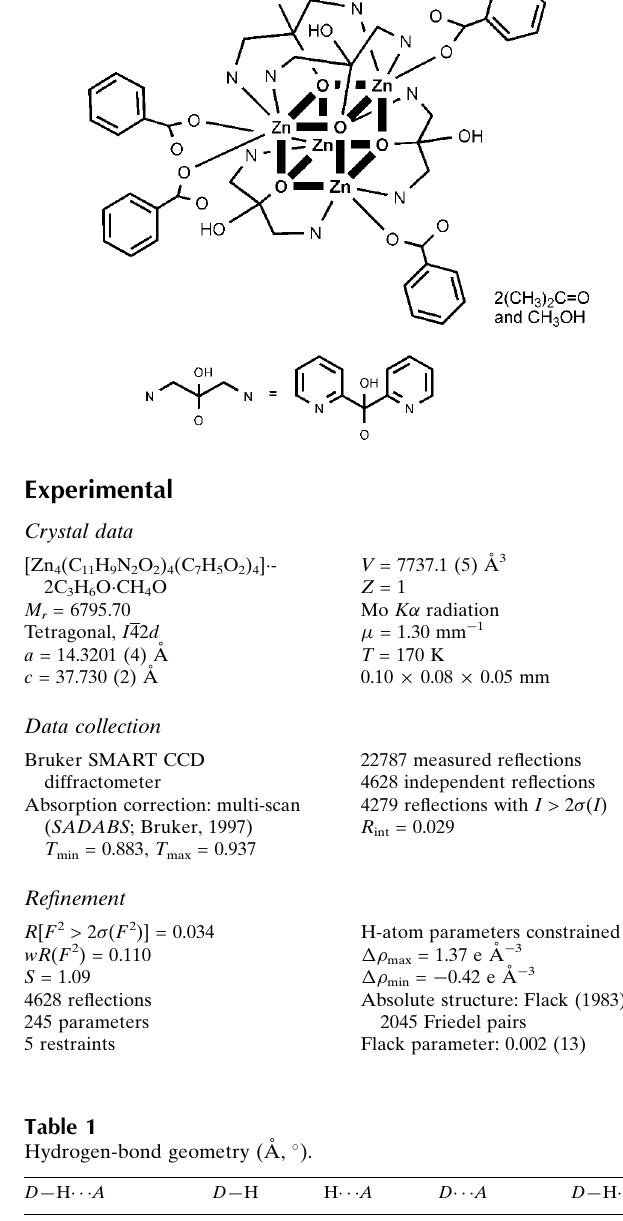
Experimental Crystal data